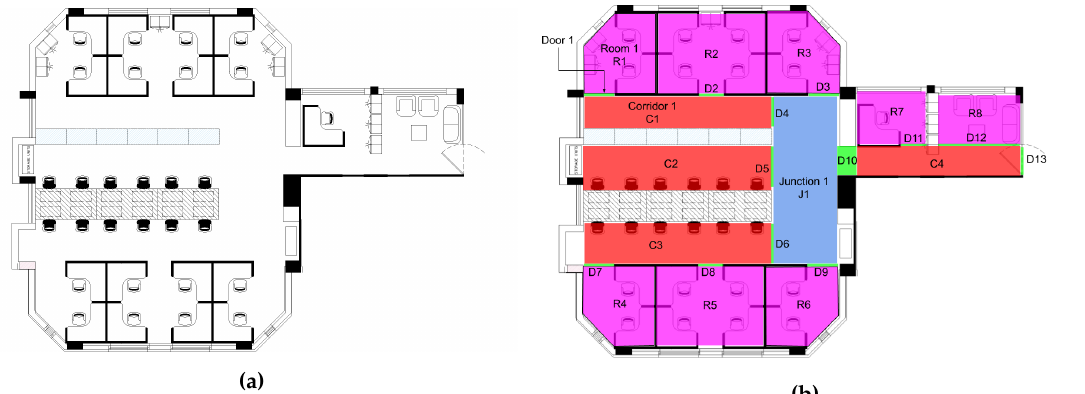
Figure 7. ( a ) A big lab space which is considered as the space type Hall. ( b ) Subdivision of this space into individual classes—Rooms (R#, pink), Corridors (C#, red), Junctions (J#, blue) and Openings (D#,